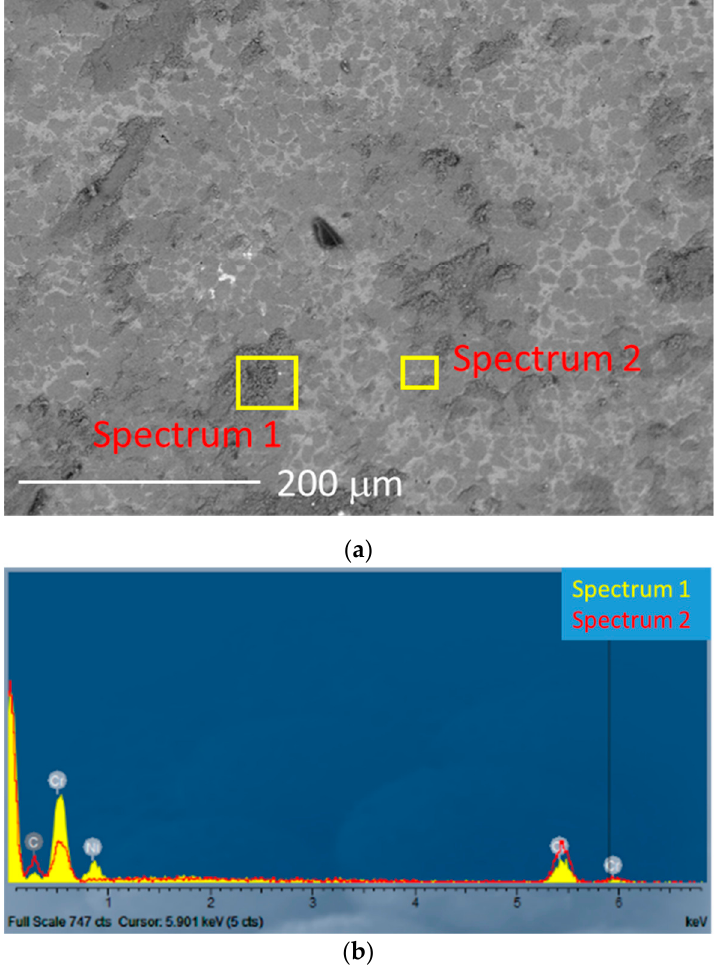
Figure 18. SEM micrograph ( a ) and EDS analysis ( b ) of Cr 3 C 2 -Ni Cr.